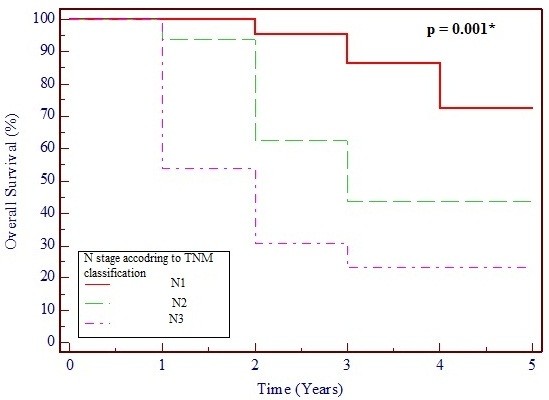
Kaplan–Meier survival curve based on lymph node stage, showing 95% confidence interval (CI).p < 0.5 is considered statistically significant.